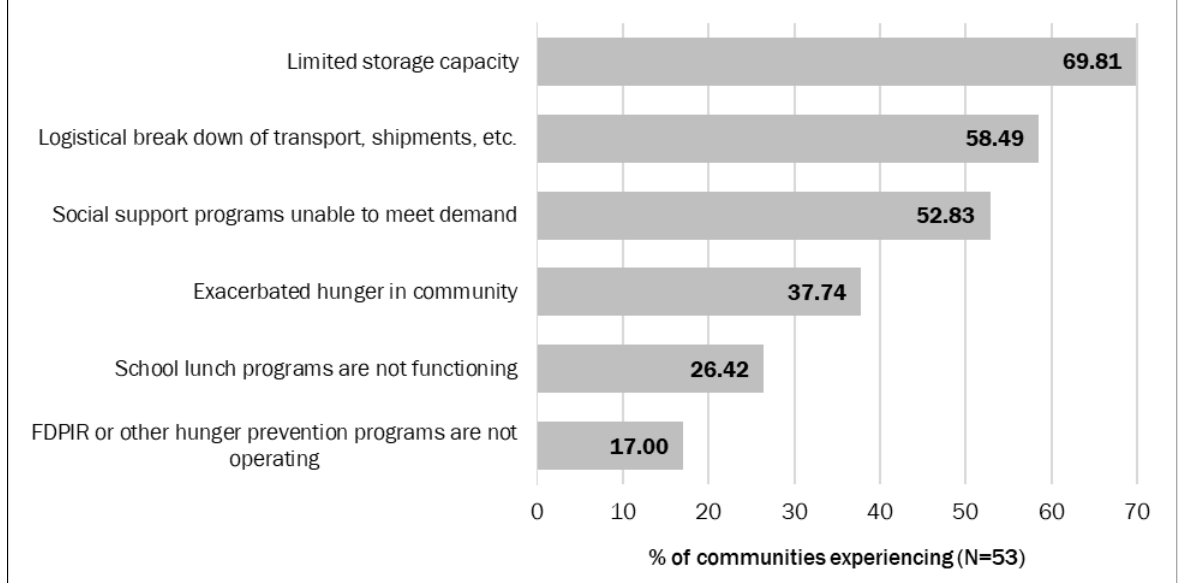
Figure 1. Proportion of Tribal Communities Experiencing Each Food System Challenge During Spring and Summer 2020 of the First Year of the Pandemic FDPIR=Food Distribution Program on Indian